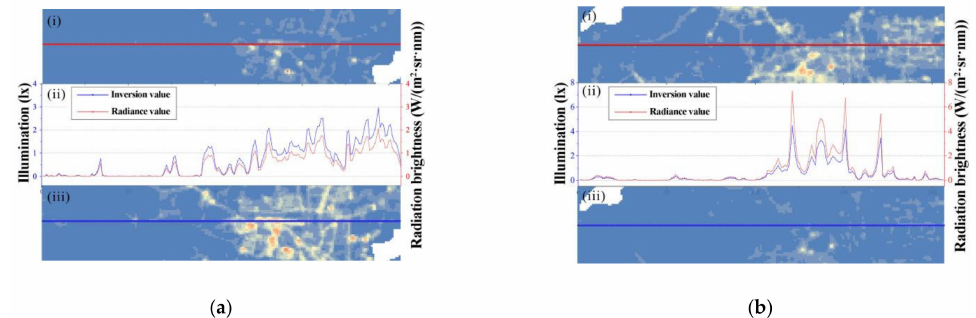
Figure 18. Comparison of illuminance inversion data and luojia-01 data. ( a ) Value region A; ( b ) Value region B; ( i ) Luojia-01 remote sensing data; ( ii ) Compare the line chart; ( iii ) Illuminance inversion data.